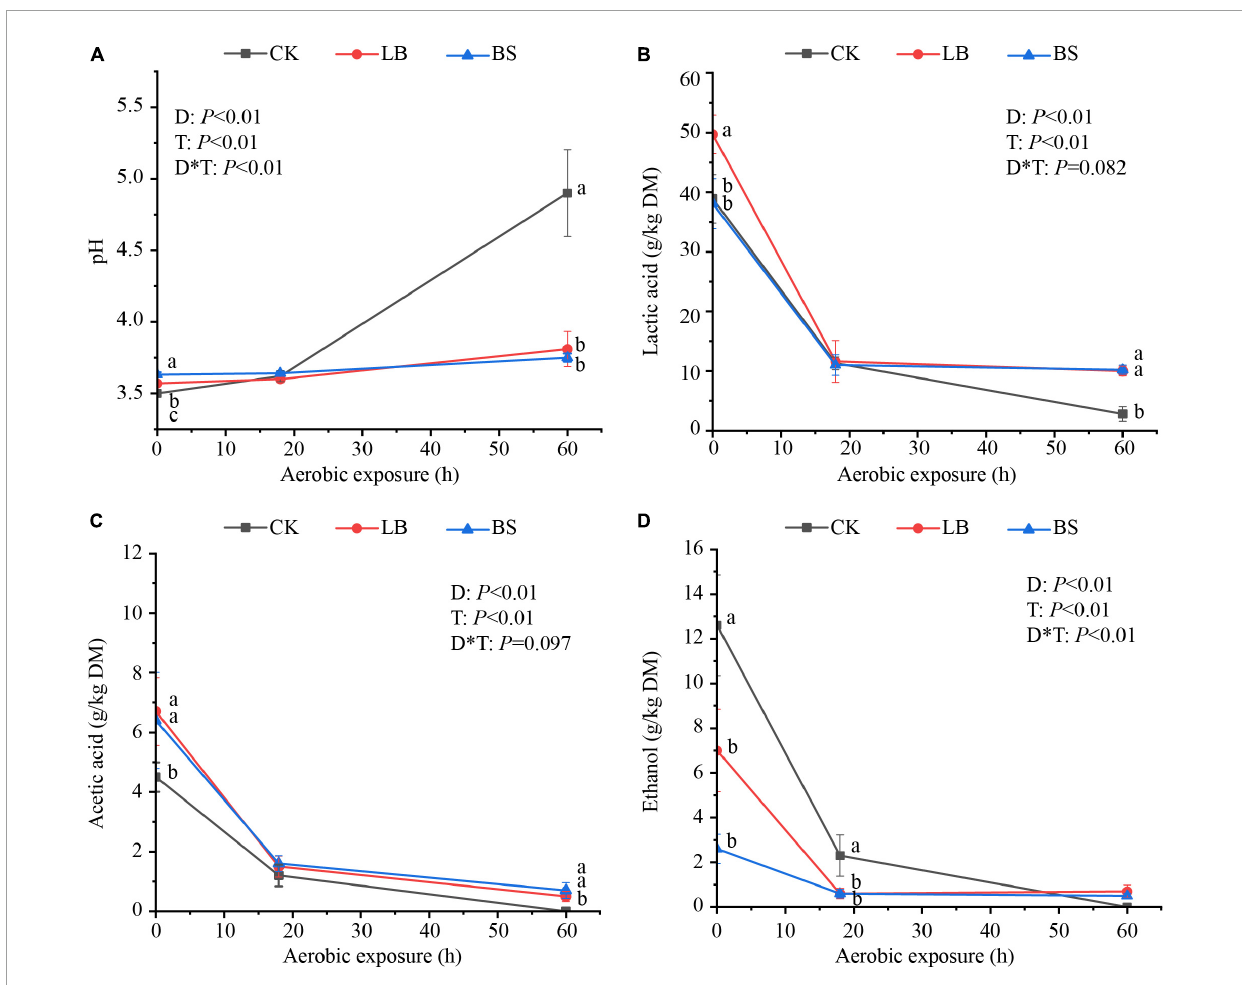
FIGURE2 Fermentation quality ( A , pH; B , lactic acid; C , acetic acid; D , ethanol) of whole plant corn silage during aerobic exposure. Means with different lowercase letters (a–c) indicate significant differences in different treatments at the same time ( P < 0.05). D, Aerobic exposure time; T, treatment; D ∗ T, interaction between aerobic exposure time and treatment; CK, control; no inoculations; LB, silages inoculated with Lentilactobacillus buchneri ; BS, silages inoculated with Bacillus subtilis